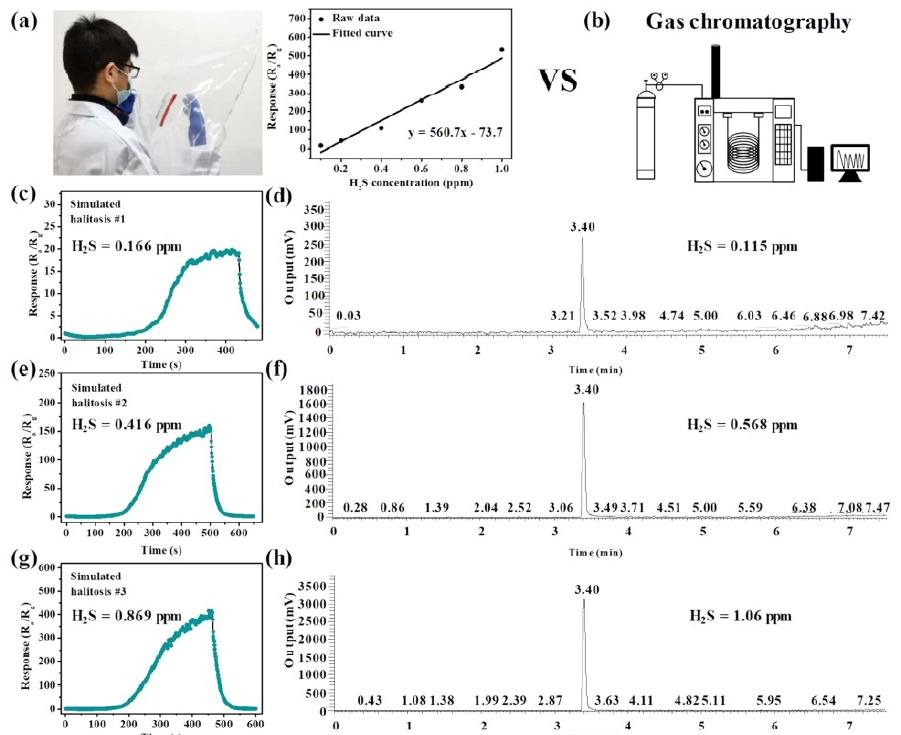
Figure 10. ( a ) Photo of NiO/WO 3 NP sensor prototype’s collection of exhaled breath and its response. ( b ) For the comparison, the gas chromatography setup is used. The corresponding sensor response of prototype to ( c ) simulated halitosis no. 1, ( e ) simulated halitosis no. 2, and ( g ) simulated halitosis no. 3. The gas chromatogram corresponding results for ( d ) simulated halitosis no. 1, ( f ) simulated halitosis no. 2, and ( h ) simulated halitosis no. 3 Reprinted/adapted with permission from Ref. [138]. Copyright 2021 American Chemical Society.